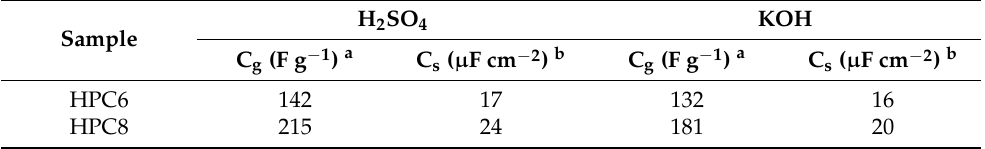
Figure 4. Supercapacitive performance for HPCs in 1 M H 2 SO 4 with a three-electrode configuration: ( a ) CV curves at a scan rate of 50 mV s − 1 , ( b ) GCD curve at a current density of 2 A g − 1 , ( c ) specific capacitances at different current densities. Table 3. Gravimetric and areal capacitances for HPCs in different electrolytes.